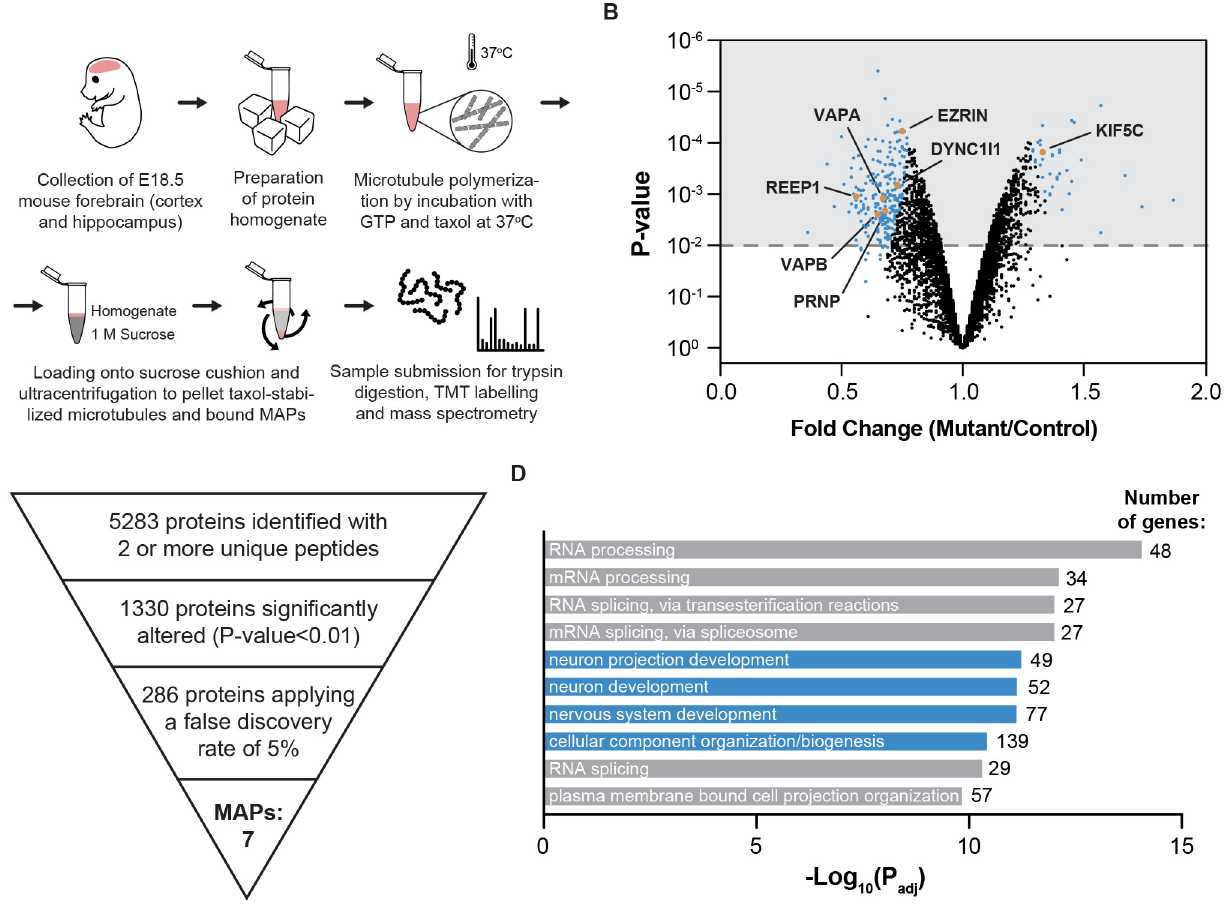
Fig 5. The R402H mutation alters the microtubule proteome. (A) Graphical depiction of the protocol employed to isolate microtubules and microtubule- associated proteins (MAPs) from the forebrain of E18.5 R402H/R402H ; Emx1-cre mutants and R402H/R402H littermate controls (n = 4). (B) Volcano plot showing the results of our mass spectrometry analysis. In total we identified 5283 proteins, of which 1330 were significantly altered in R402H/R402H ; Emx1-cre mutants (P < 0.01) (shown in grey). These were narrowed to 286 proteins upon application of a false discovery rate of 5% (shown in blue). (C) Pyramid showing how we filtered our mass spectrometry dataset, resulting in the identification of seven known MAPs highlighted in orange in (B). (D) Gene ontology analysis performed with g:Profiler on the 286 proteins revealing enrichment for GO terms associated with cellular organization and nervous system development (highlighted in